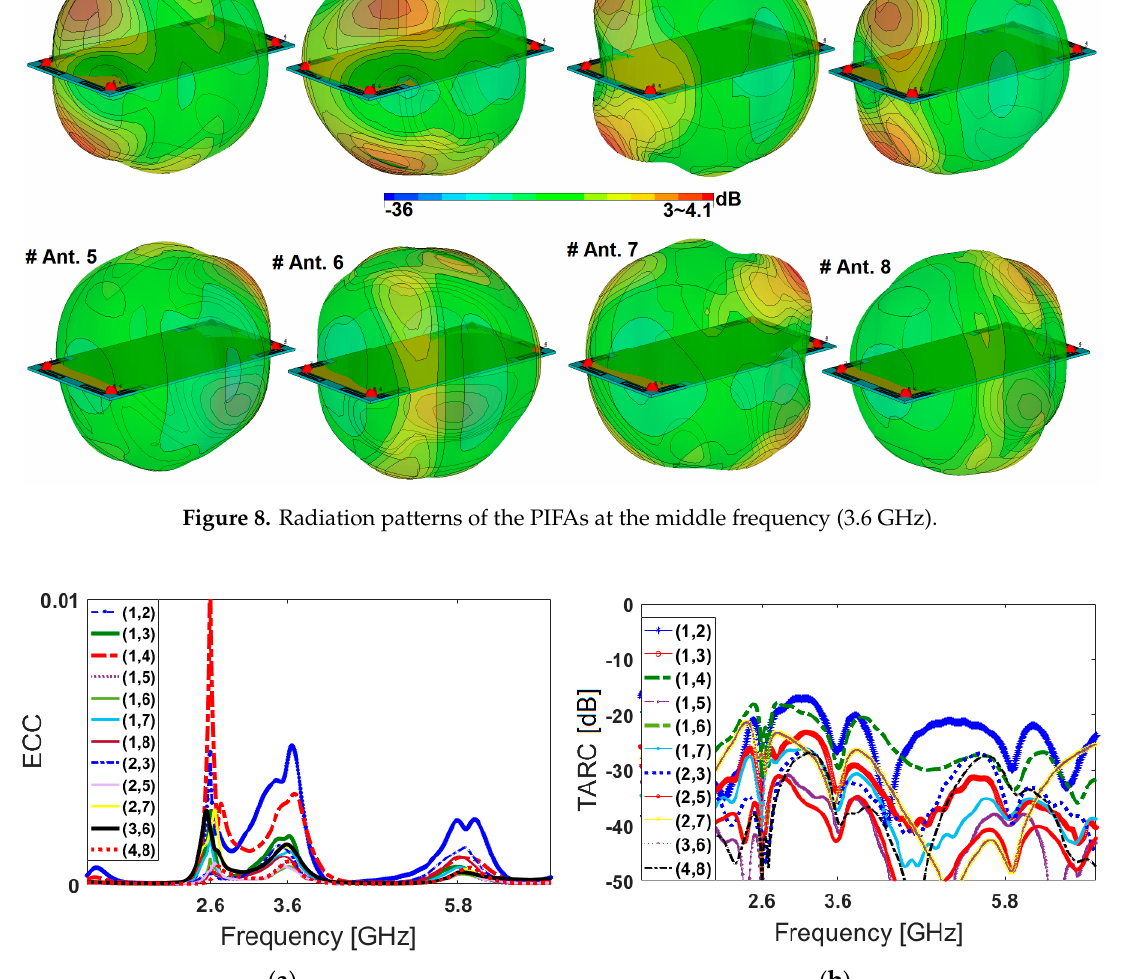
Figure 9. Calculated ( a ) ECC and ( b ) TARC results of the proposed design.